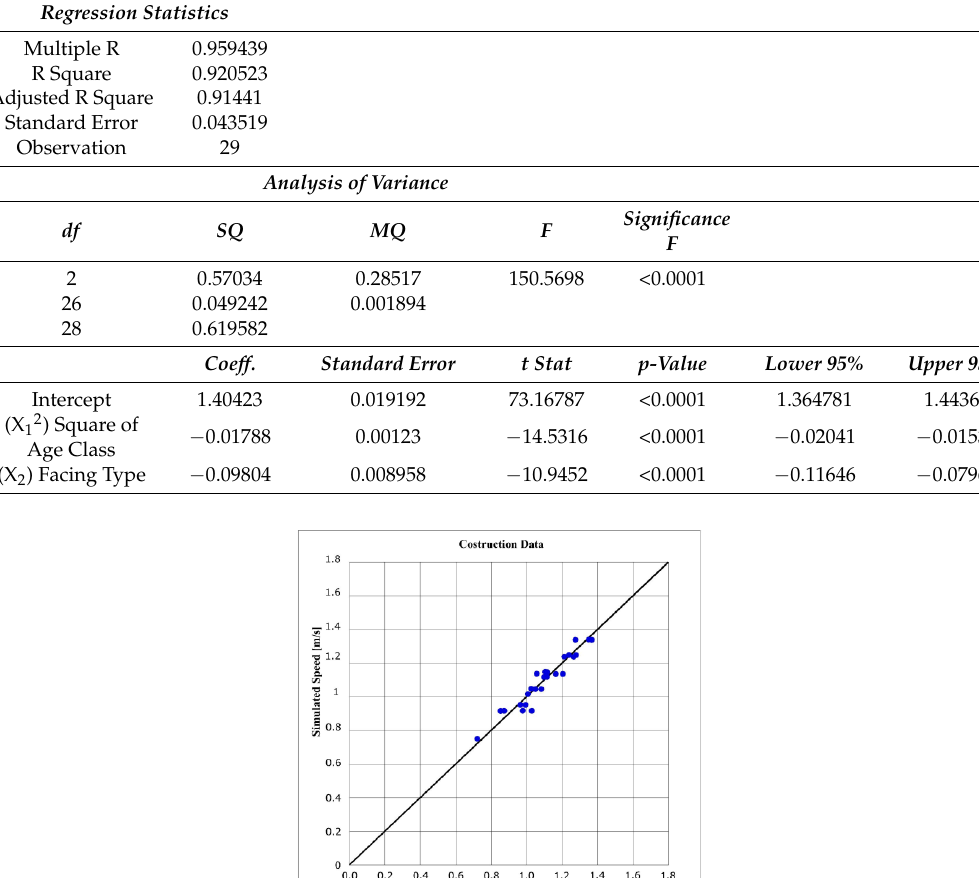
Table 6. Global model: regression statistics and ANOVA.